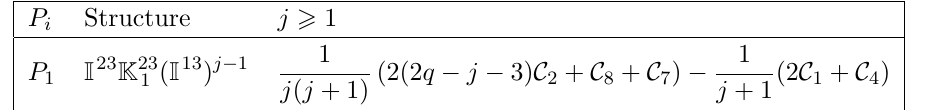
Table 17 . Expansion of the supersymmetric correlator in the component has spin (0 ; 1 ( j 1)) and QO has spin ( 1 2 (cid:0)